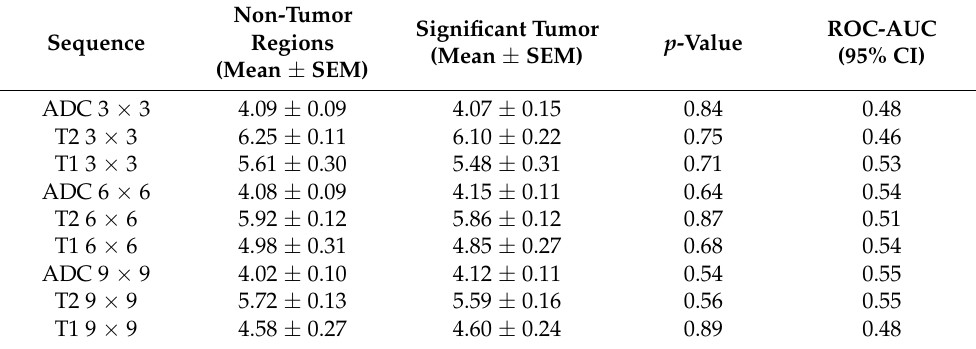
Table 5. Illustrating mean ± SEM value of the ADC map and T 2 - and T 1 -weighted images acquired from a first-order statistical analysis of entropy for ROIs containing non-tumors and significant tumors. p -values of differences between ROIs were computed using two-tailed Mann–Whitney U testing. The comparison between ROIs, including tumors and non-tumors, was assessed according to the area under the receiver operator characteristic curve (ROC-AUC) for mp-MRI TA